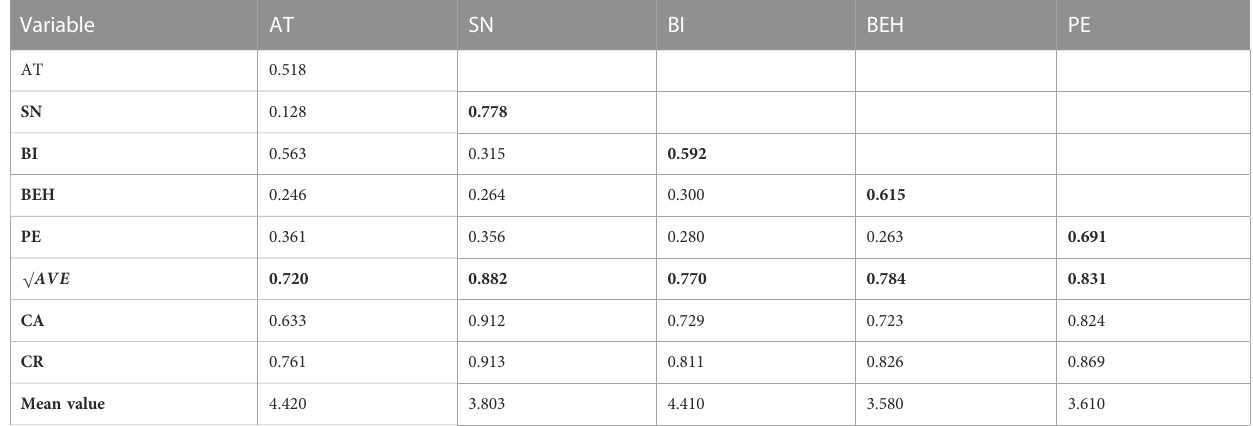
TABLE 2 Sample reliability test and validity test. Variable